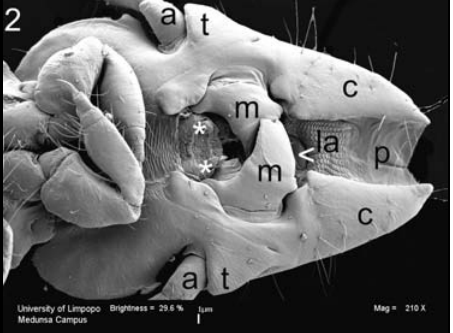
Fig. 4. SEM of the mandible showing the notched cutting edge (arrow).